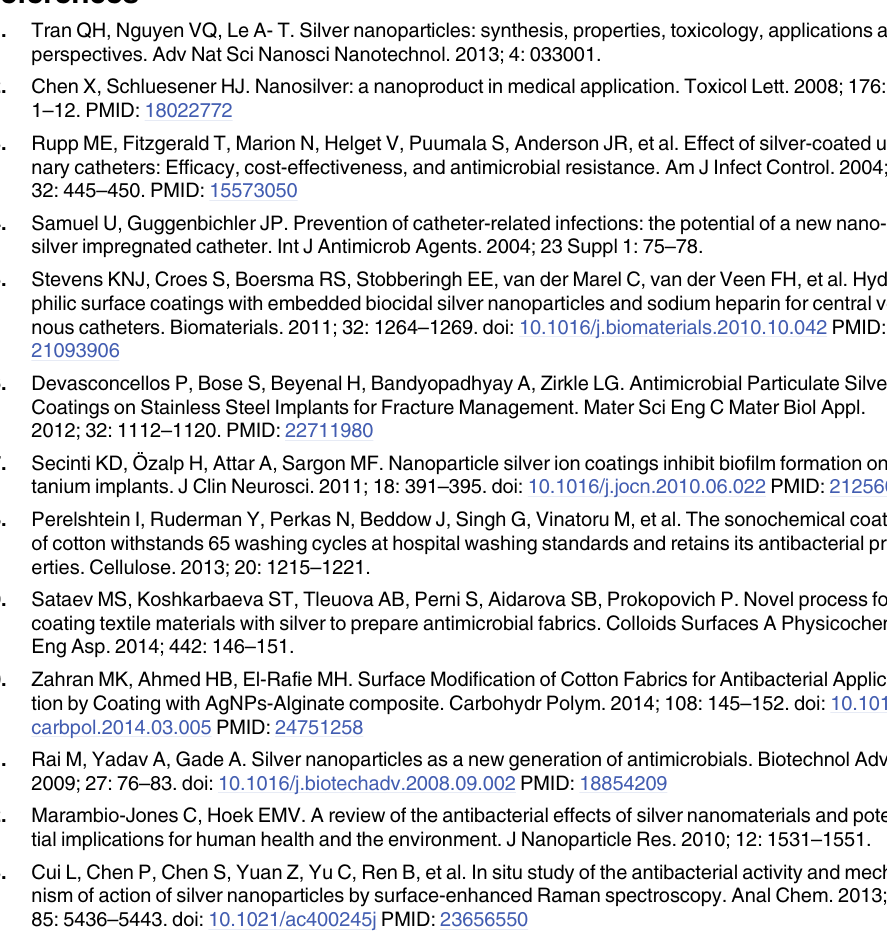
S3 Fig. Cyclic voltammograms of Ag + ions in the presence of PEG, PVP, PVA and HEC under the scanning rate equal to 0.1 V/s. (TIF) S4 Fig. Cyclic voltammograms of Ag + ions in the presence of PEG, PVP, PVA and HEC under the scanning rate equal to 1 V/s. (TIF) S1 Table. The concentrations (mg/L) of Ag + ions in studied